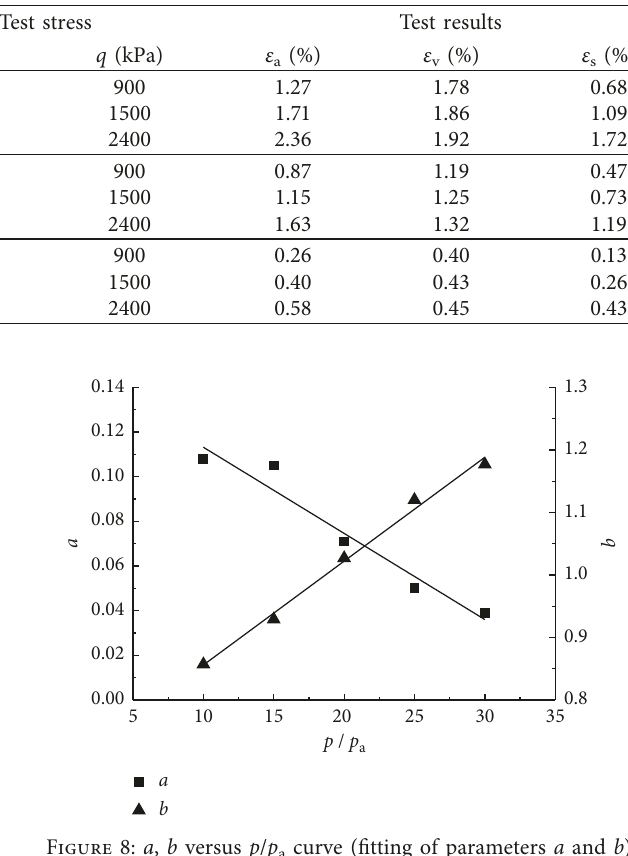
Table 6: Test stress conditions and test results (different mother rocks).